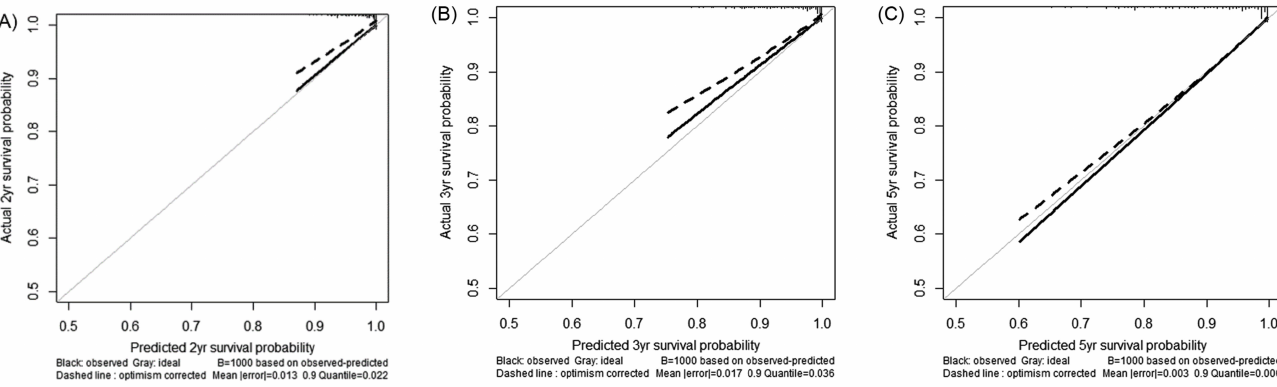
Figure 3. Calibration plot of risk prediction model at 2 ( A ), 3 ( B ), and 5 years ( C ) after initiation of antiviral